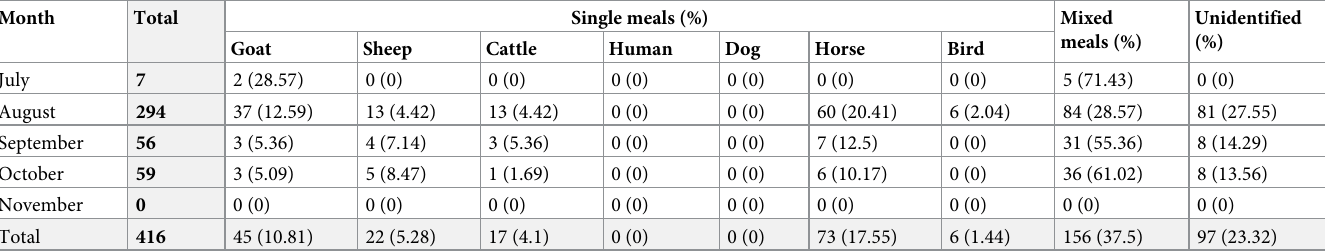
Table 4. Variation of blood meals number taken on hosts along the study